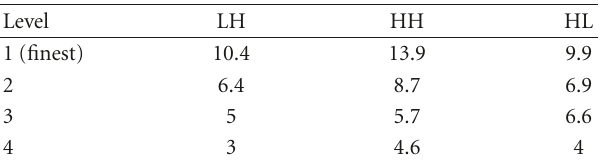
Table 5: Optimum threshold of subbands for Cameraman and σ w = 10.